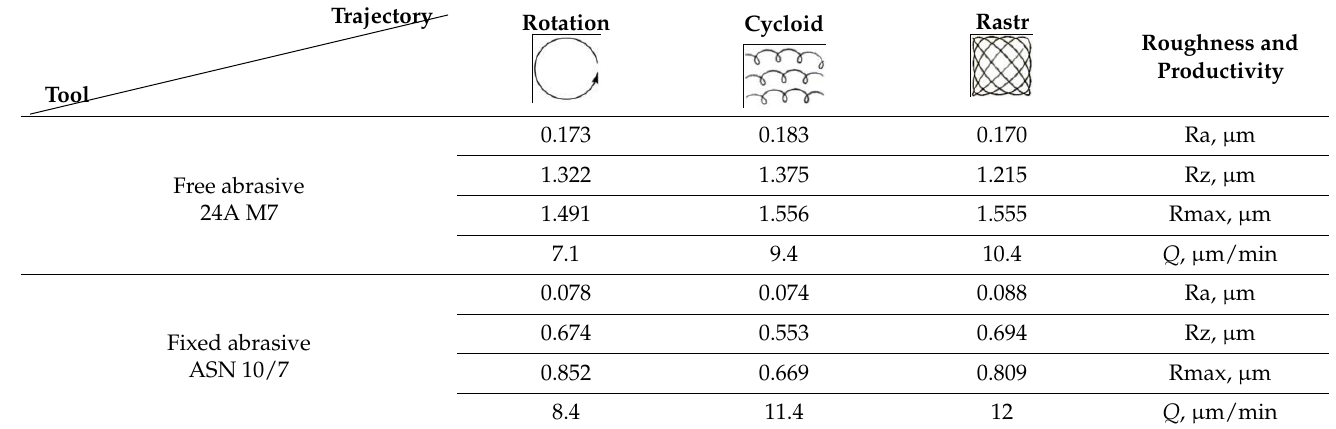
Table 1. Kinematics influence on the parameters of the lapping process.